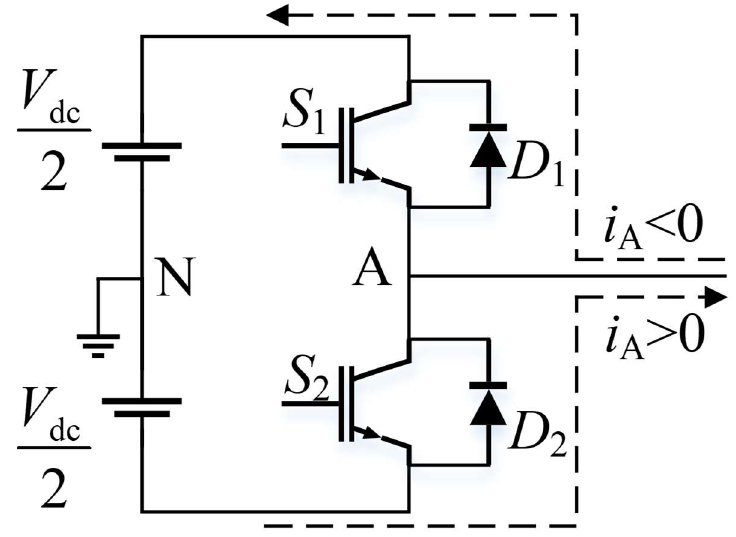
Figure 3. Basic configuration of the leg of phase A.